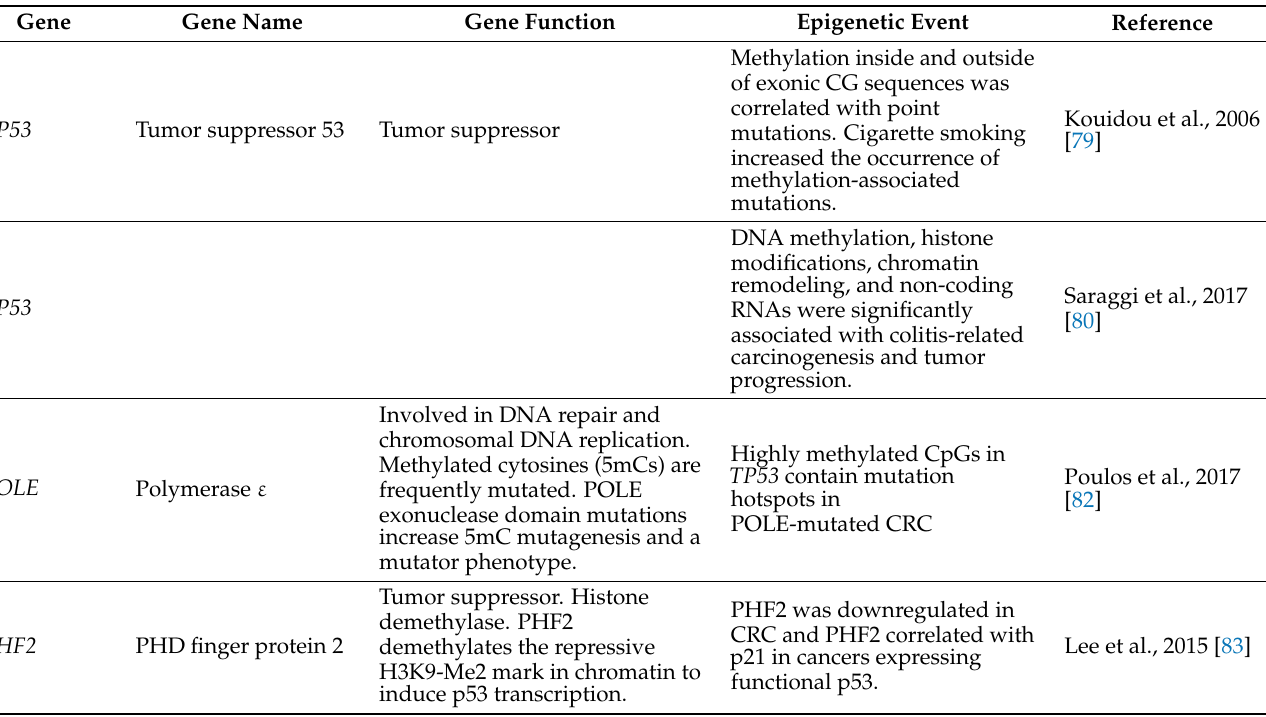
Table 3. Epigenetic alterations at TP53 as target